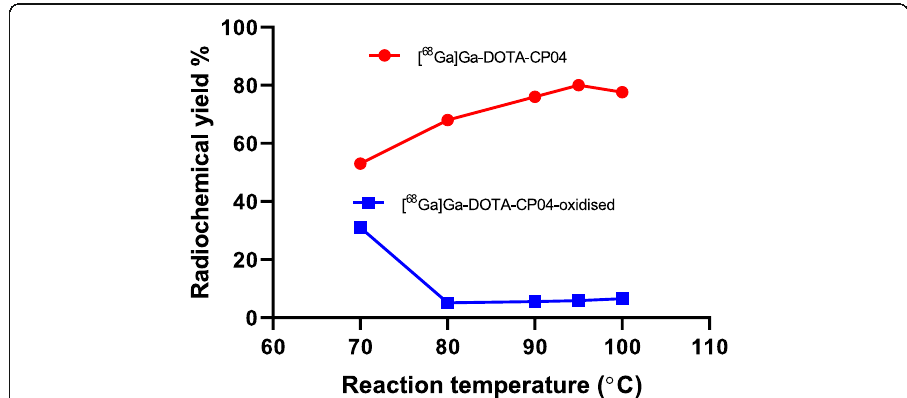
Fig. 4 Effect of reaction temperature on formation yield of [ 68 Ga]Ga-DOTA-CP04 (red) and its oxidized byproduct [ 68 Ga]Ga-DOTA-CP04-oxidised